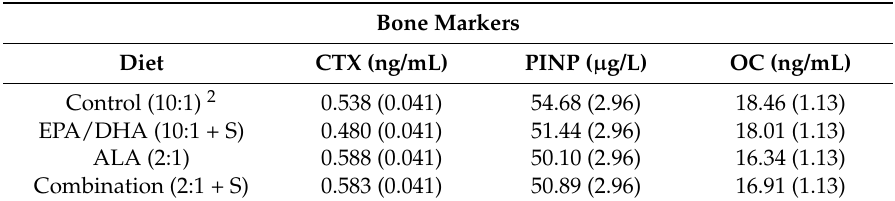
Table 1. Mean concentrations of serum bone markers at the end of each experimental diet 1 . Bone